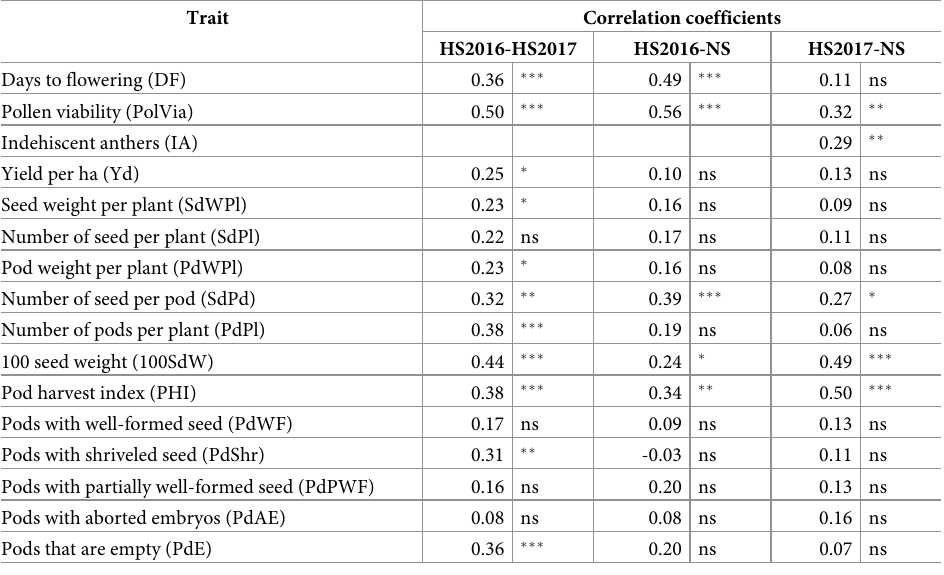
Table 2. Phenotypic correlations between trials in heat stress (HS) and non-stress (NS).